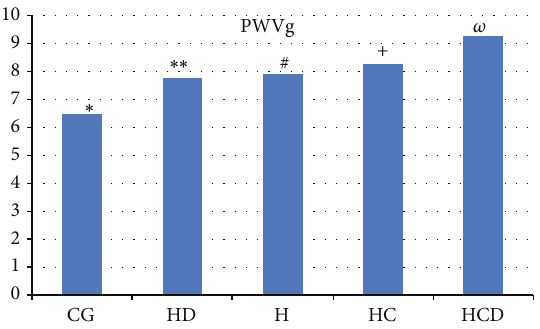
Figure 1: Significant statistical difference in PWVg between HDC women and each other group. 𝜔 versus ∗ 𝑃 < 0.0005 , 𝜔 versus ∗∗ 𝑃 < 0.05 , 𝜔 versus # 𝑃 < 0.01 , and 𝜔 versus + 𝑃 < 0.03 . CG: controlgroup,H:hypertensivepostmenopausalwomen,HD:hyper- tensive and diabetic postmenopausal women, HC: hypertensive and hypercholesterolemic postmenopausal women, HDC: hypertensive, diabetic,andhypercholesterolemicpostmenopausalwomen,PWVg: pulse wave velocity